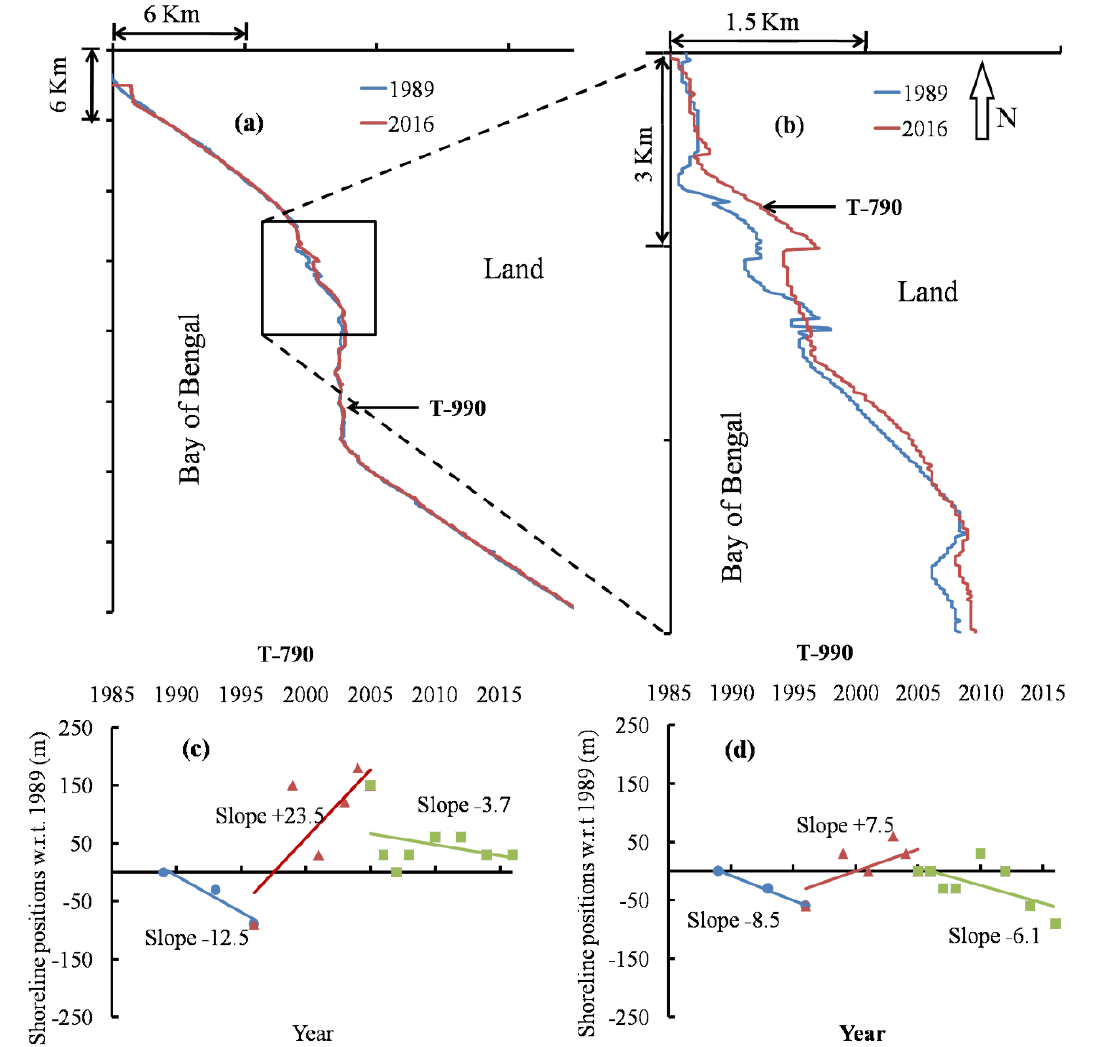
Figure 9. ( a ) Shoreline positions along Cox’s Bazar in 2016 (red) and 1989 (blue), ( b ) zoomed view of the shoreline positions (black square in ( a )), ( c ) shorelines relative to 1989 for transect no. T-790, ( d ) shorelines relative to 1989 for transect no. T-990.